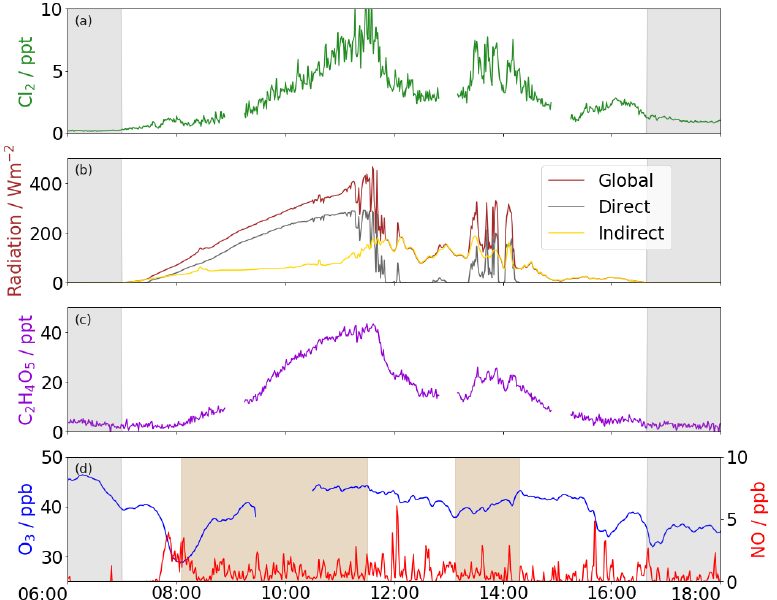
Figure 2. Time series for 1 November 2014, with (a) Cl 2 , (b) solar radiation (global, direct and indirect), (c) photochemical marker C 2 H 4 O 5 , and (d) O 3 and NO x , where highlighted boxes demonstrate that (cid:49) production when VOC limited are strongly coupled with direct solar radiation. Greyed areas are night time.